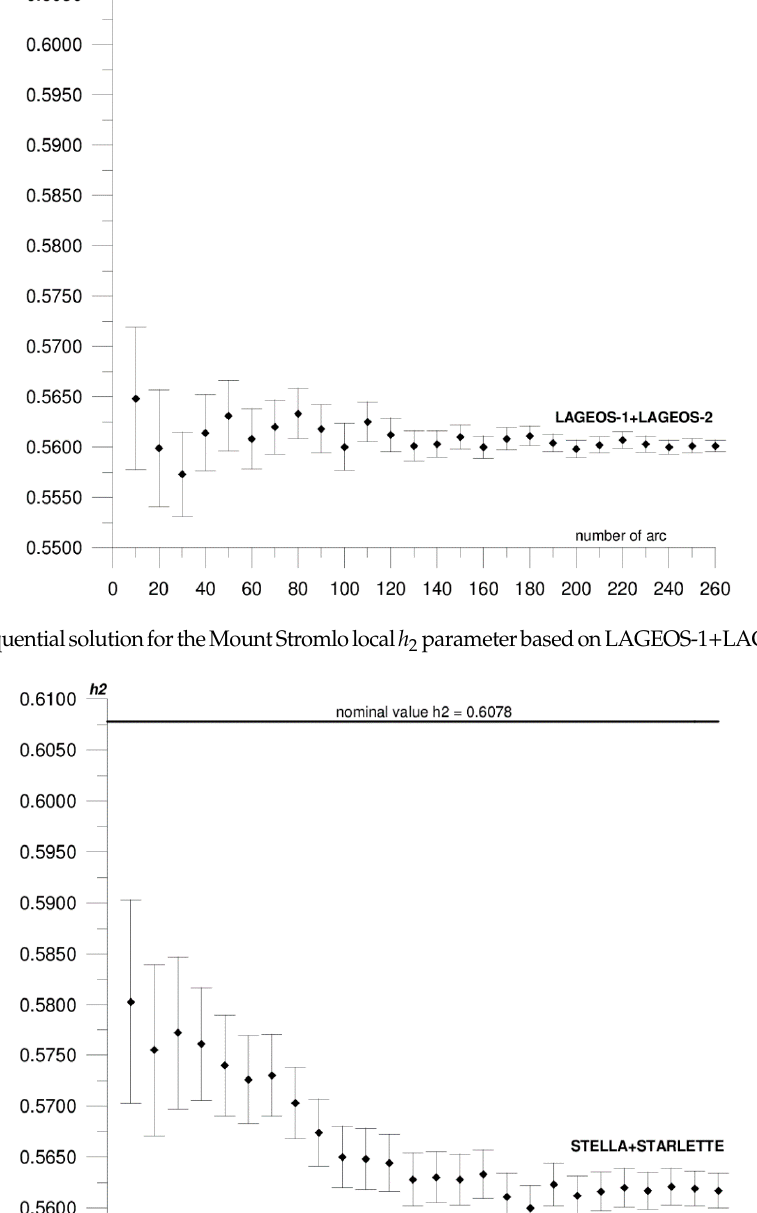
Figure 4. Sequential solution for the Yarragadee local l 2 parameter based on LAGEOS-1+LAGEOS-2 data.